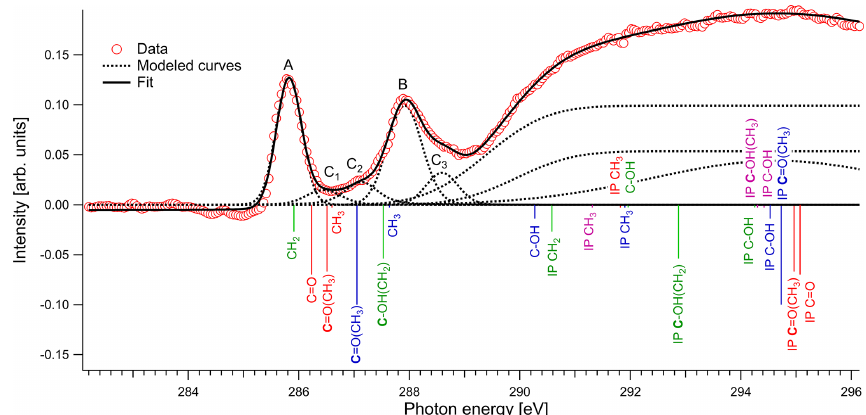
Figure 5. Normalized spectrum of 1M methylglyoxal with the identified and calculated peaks and ionization steps. The calculated values are presented with red color for the unhydrated methylglyoxal, blue color for the monohydrated methylglyoxal, purple color for the dihydrated methylglyoxal and green color for the enol form. The calculated vertical lines have been scaled according to the calculated oscillator